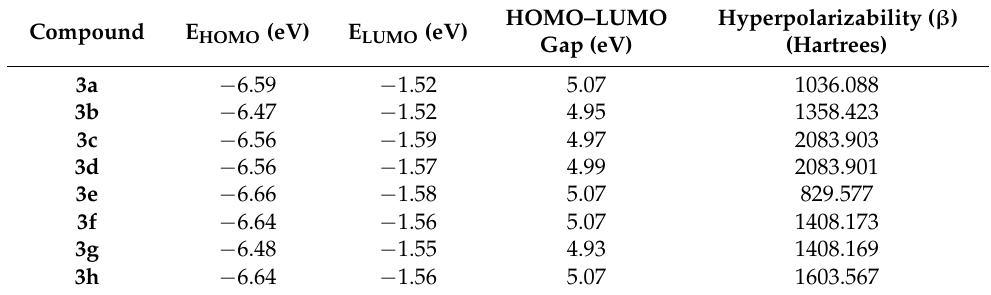
Table 7. Energies of the HOMO, LUMO, HOMO–LUMO energy gap and hyperpolarizability ( β ) values of compounds 3a – 3h